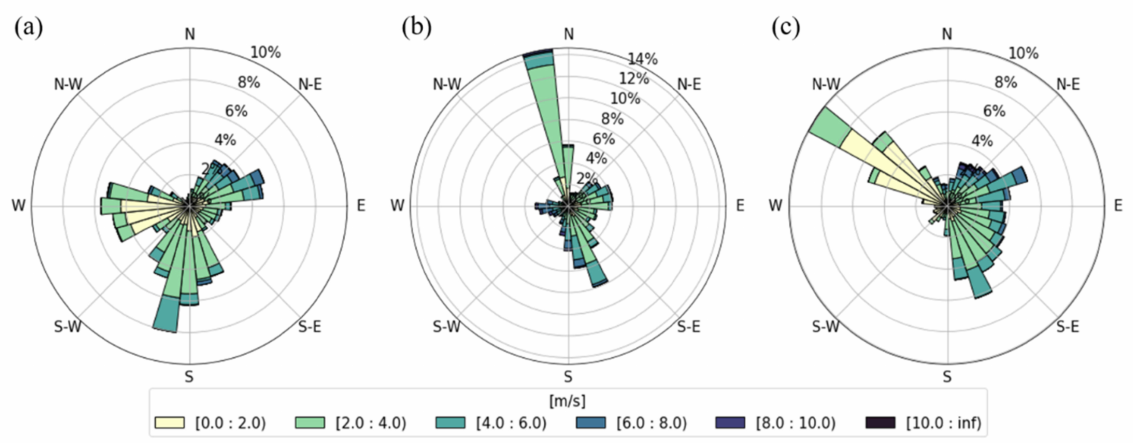
Figure 5. Wind rose diagrams from Barcelona ( a ), Tarragona ( b ), and Castell ó n ( c ) harbours. Concen- tric circles represent the percentage of occurrence, colours denote wind speeds in metres per second, and directions are “winds coming